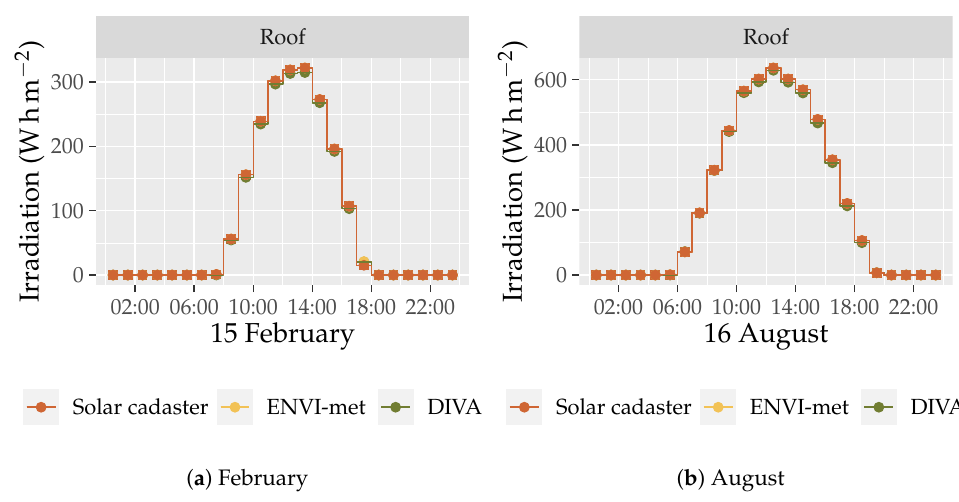
Figure 10. Spatial average of the irradiance received on the unshaded roofs (homogeneous neighbor- hood or buildings 6 and 7 of the heterogeneous neighborhood).